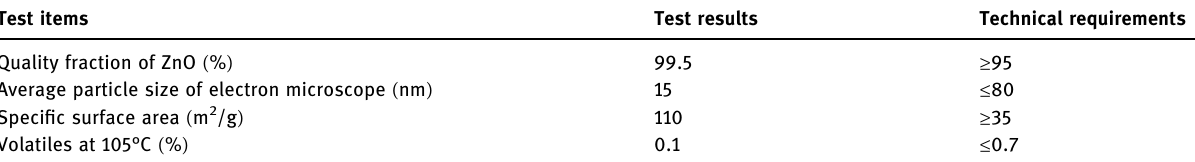
Table 3: Technical indicators of nano - ZnO Test items